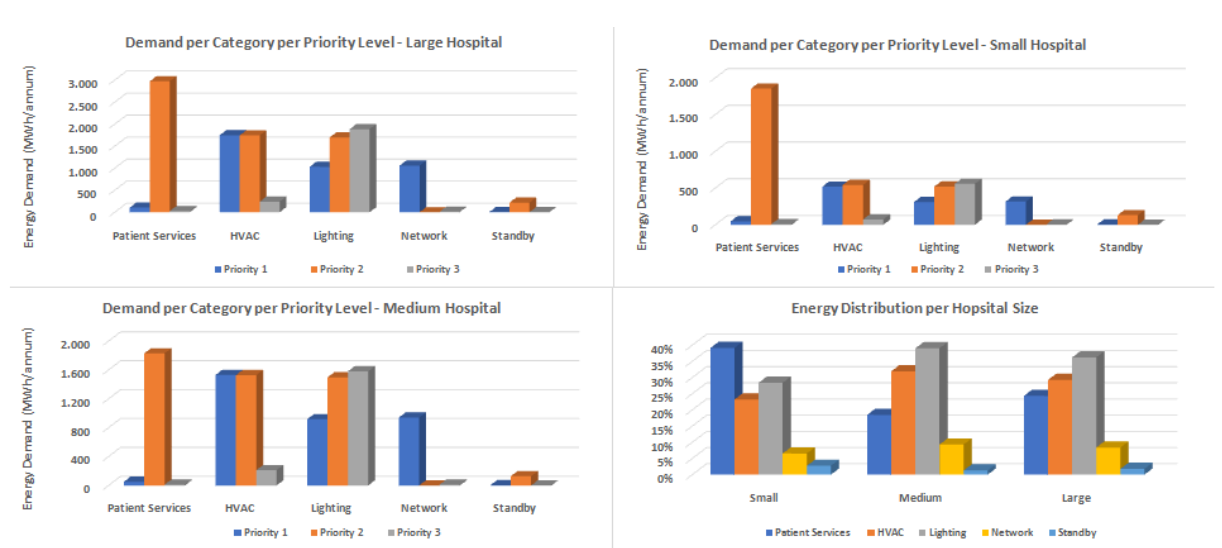
Figure 4. Energy demand distributions for Priority 1, 2 and 3 activities for small, medium, and large hospitals Priority 2 activities have the highest electrical energy demand (as seen in the top row, and left frame of